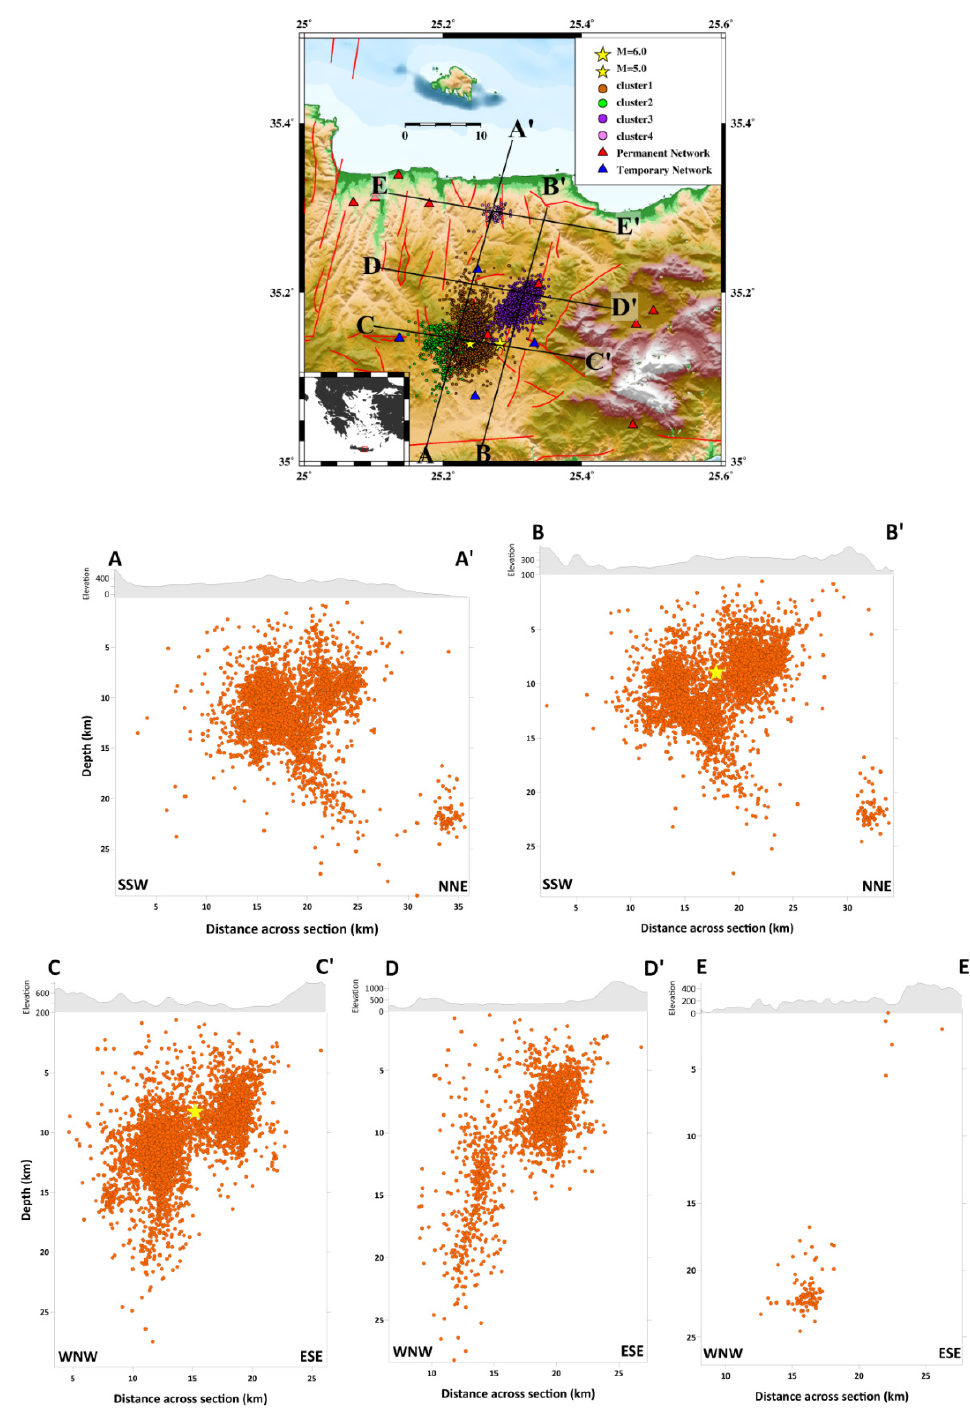
Figure 5. Presentation of the map of the 5 cross-sections, 5 km wide ( A – A’ , B – B’ , C – C’ , D – D’ , and E – E’ ) on the left side of the figure and the results of the SSW-NNE oriented cross-sections (upper panel) and the results of WNW-ESE oriented cross-sections (lower panel) on the right side. The projection of the 27 September mainshock is depicted by yellow star on sections ( B – B ’) and ( C – C’